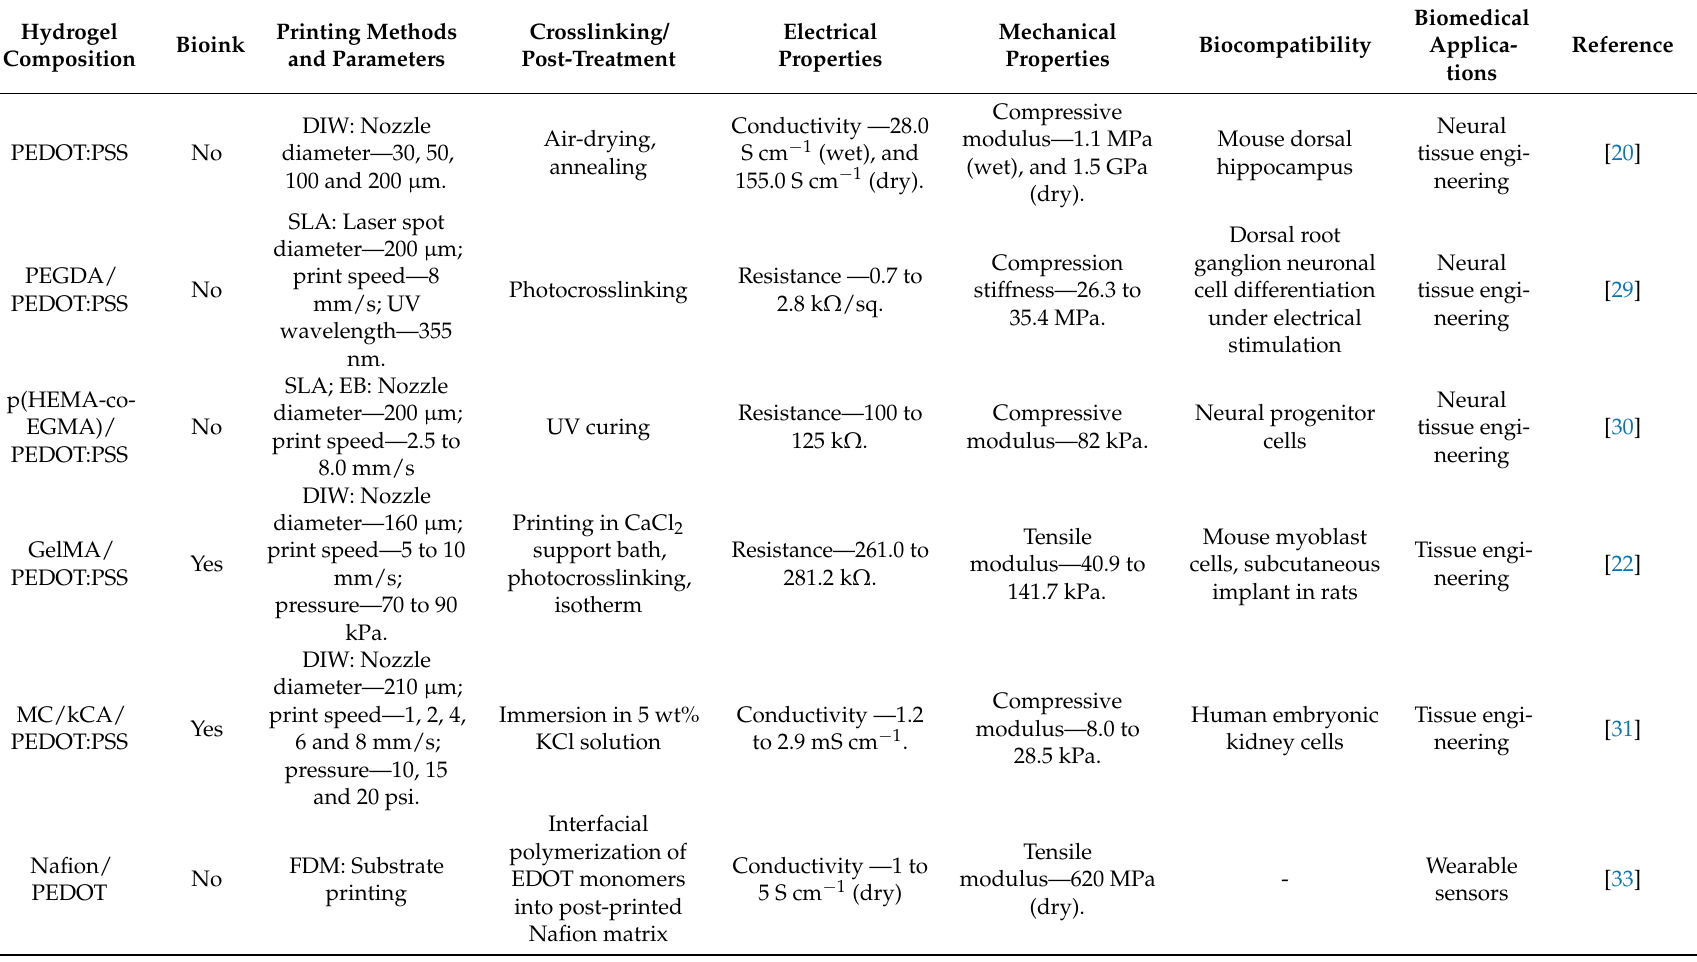
Table 1. Summary of 3D printed electrically conductive polymer-based hydrogels and scaffolds for biomedical